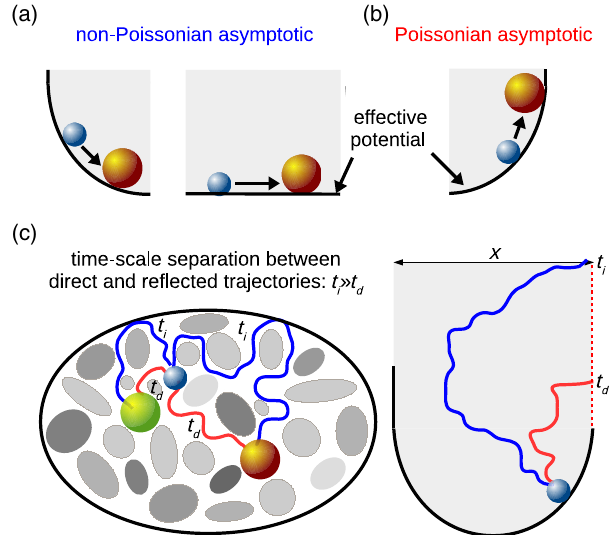
FIG. 1. Schematic of the two limiting forms of long-time FPT behavior, (a) and (b), depending on the effective potential experienced by the searcher in the vicinity of the absorbing target (originating either from an external force or from the geometric spurious drift in the radial direction). (c) Schematics of two molecules (large spheres) searching for a target (small sphere) with two different realizations of direct and indirect trajectories t and t , respectively, depending on the initial d i distance to the target (see text for details). As soon as a time- scale separation exists between t and t , a robust proximity effect d i emerges, with any two t being typical and very similar while any d two t tend to be strongly dissimilar. This focusing of t in turn i d enables faster and more precise gene